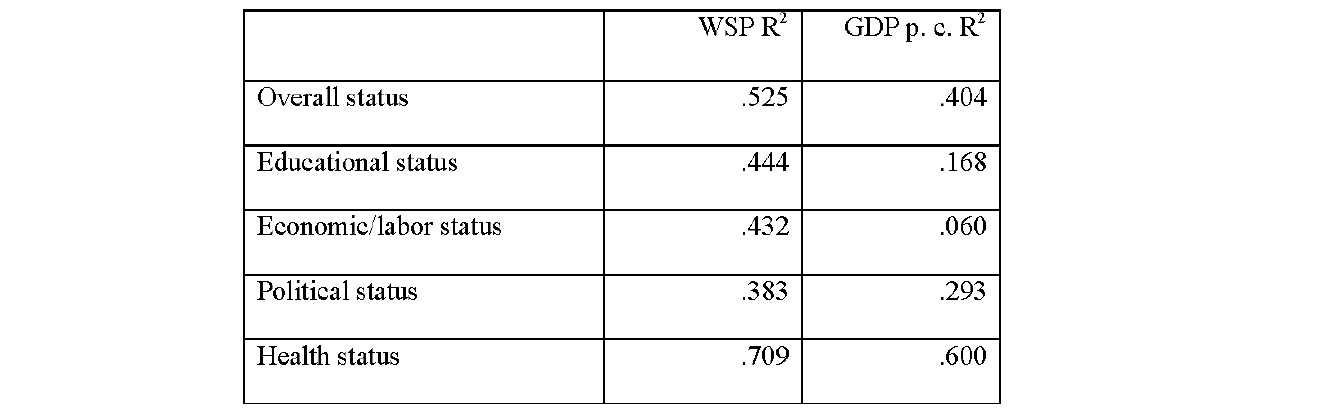
Table 3. Strength of Association (R 2 ) Between Indicators of Women's Status and Kick